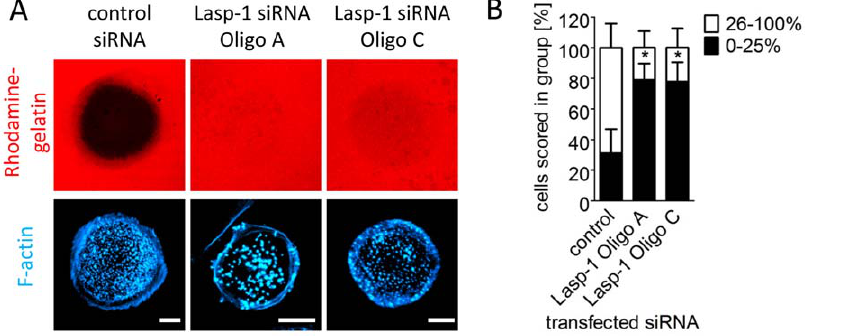
Figure 6. Knockdown of Lasp-1 impairs the matrix degradation capacity of podosomes from human macrophages. A ) Confocal micrographs of macrophages transfected with control siRNA or siRNAs (Oligo A or C) specific for human Lasp-1, and seeded on rhodamine-labeled gelatin (red). Cells were fixed after 6 h and stained with Cy5-phalloidin for F-actin (blue). Matrix degradation is visible as dark areas by concomitant loss of the fluorescent label. White bars represent 10 m m. ( B ) Statistical quantification of matrix degradation in cells treated with control siRNA or siRNAs specific for Lasp-1. Measurement of the fluorescence intensity of the degraded area was used to evaluate the degree of degradation. Complete absence of signal was set as 100% degradation and the evaluated cells were scored into groups depending on the degree of matrix degradation (0%–25%; 26%–100%). Single asterisks indicate values significantly different from control with a P value , 0.05 (means with n=3 6 30).